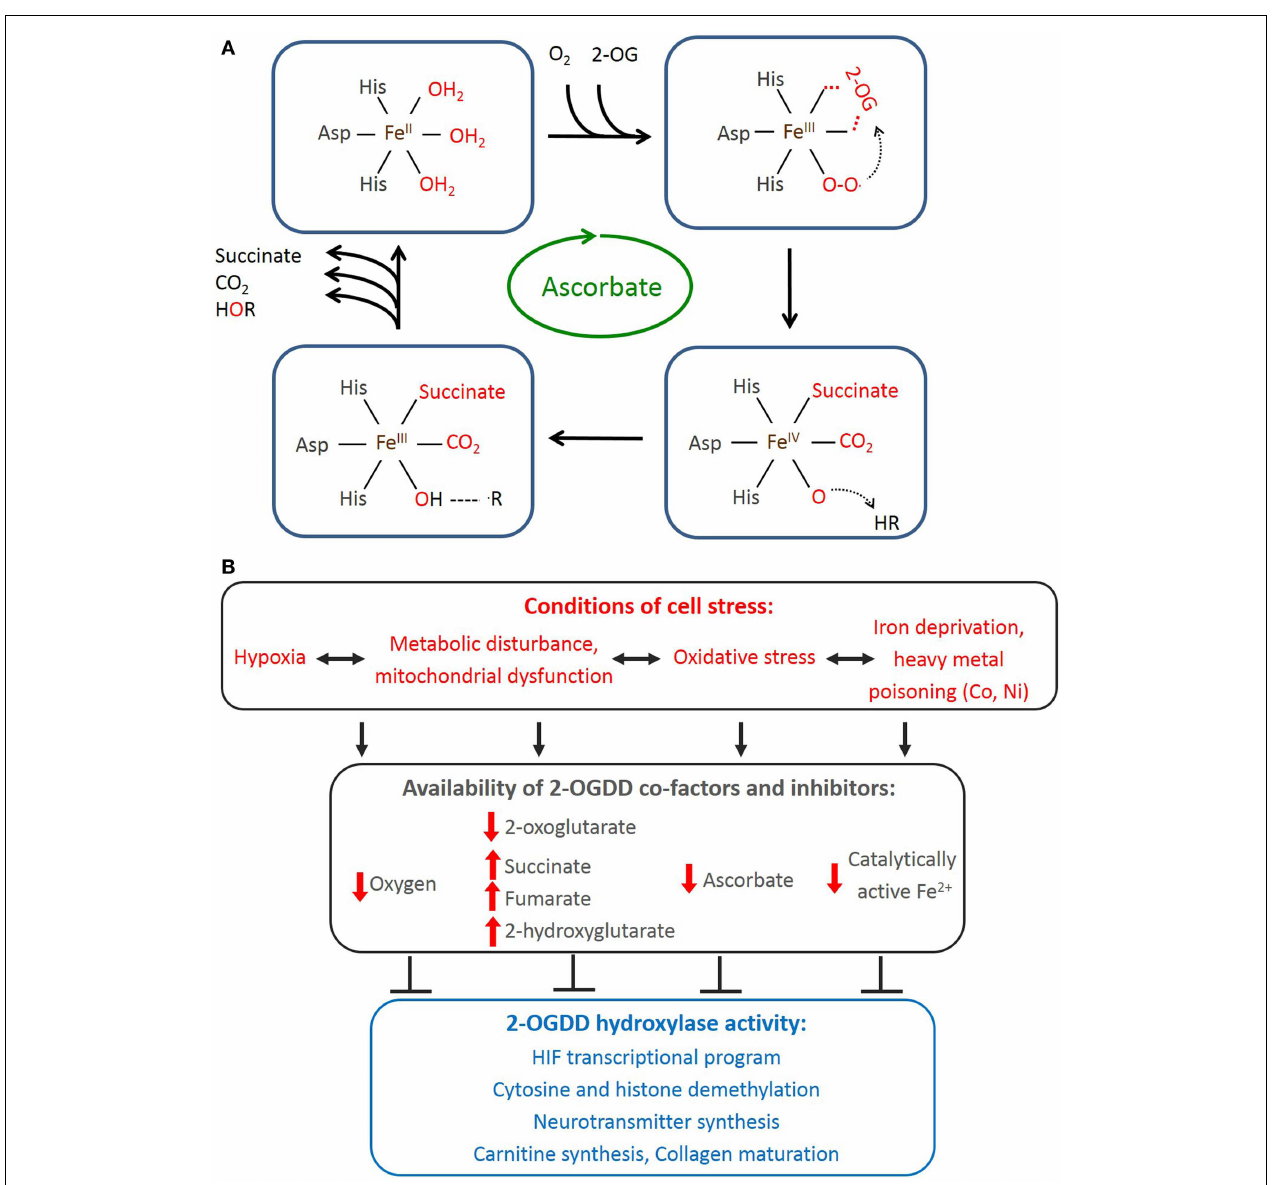
converted to succinate, releasing CO 2 . Ferrous iron and ascorbate are specific co-factors for this reaction. (B) Cellular stressors deprive 2-OGDDs of their required co-factors resulting in inhibition of multiple potential